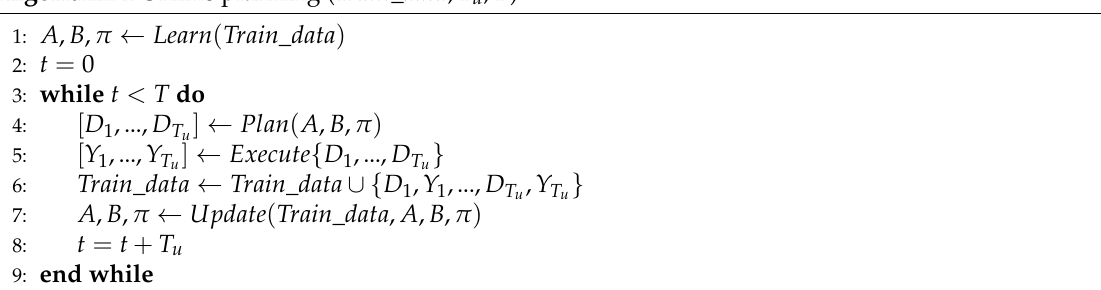
Algorithm 1 Online planning ( Train _ data , T u , T